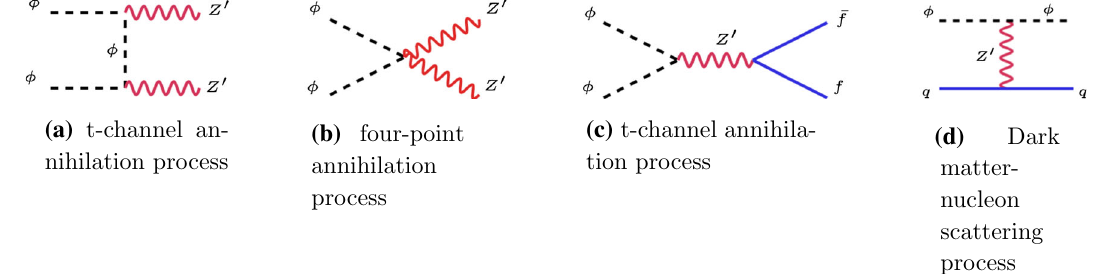
Fig. 3 Dark matter annihilation and dark matter–nucleon scattering processes in the scalar dark matter